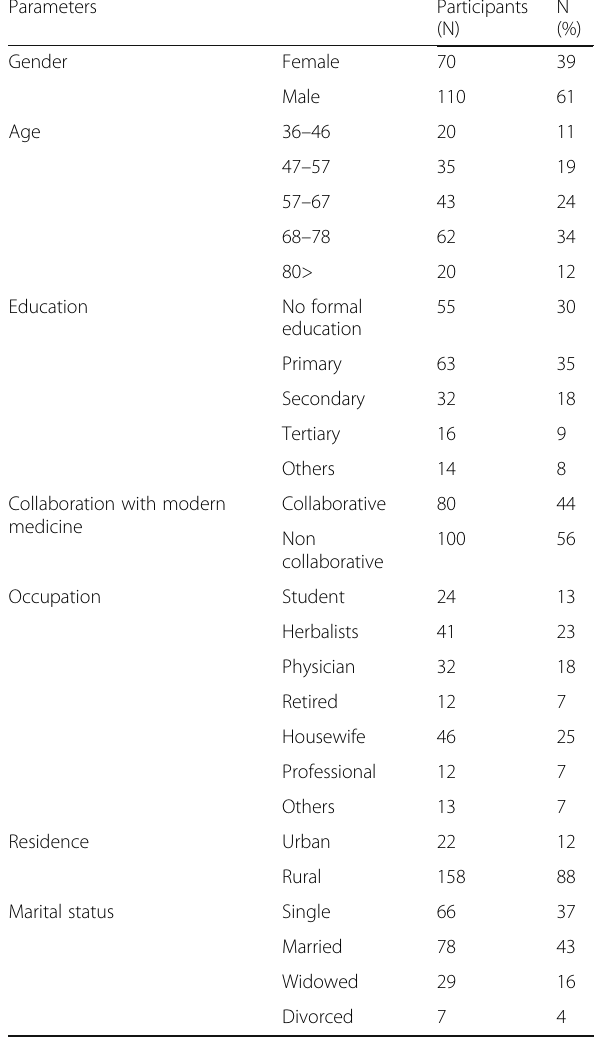
Table 1 Demographic data of